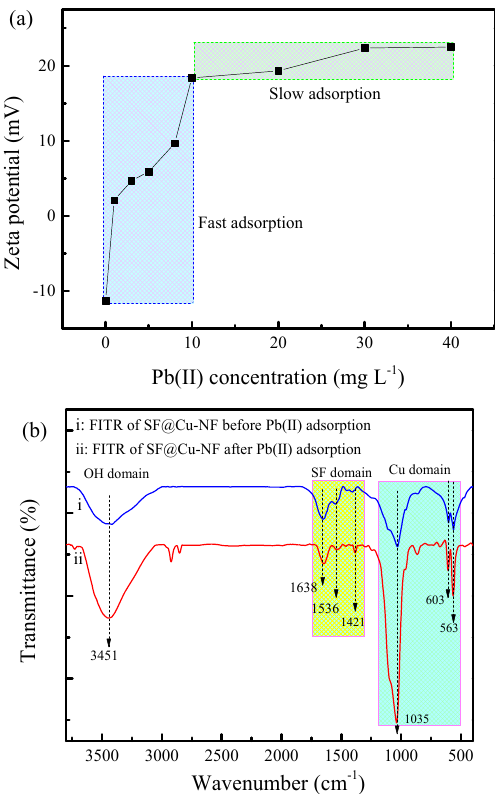
Figure 9. ( a ) Surface zeta potential measurement of SF@Cu ‐ NFs at different Pb 2+ concentrations; ( b ) FTIR spectra of SF@Cu ‐ NFs before (spectrum i) and after (spectrum ii) Pb(II) adsorption. In order to access the interactions between SF@Cu ‐ NFs adsorbent and Pb(II) ion, SF@Cu ‐ NFs after Pb(II) adsorption was furthermore investigated by zeta potential, FTIR, and XRD